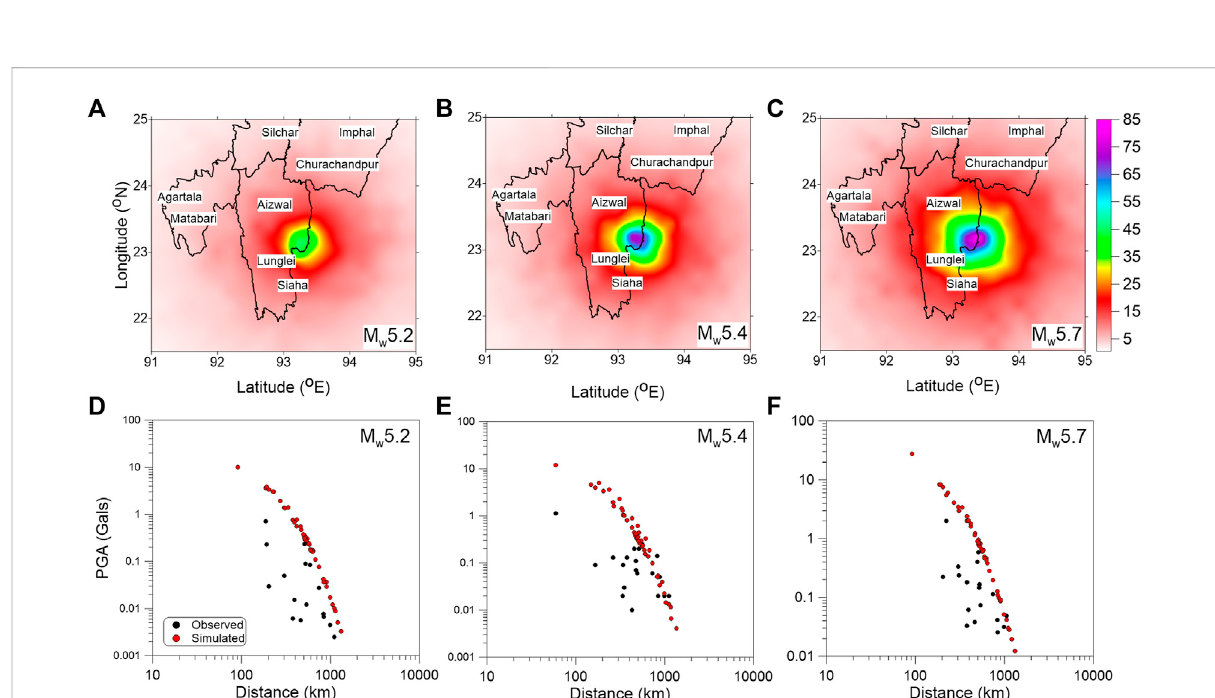
FIGURE 3 PGA distribution of simulated (A) Mw5.2, (B) Mw5.4, (C) Mw5.7 events are shown in the fi gure. The coloured scale of the simulated PGA is given on the right side of the fi gure. Comparisons between observed and simulated PGA are plotted for (D) Mw5.2, (E) Mw5.4, (F) Mw5.7 events.